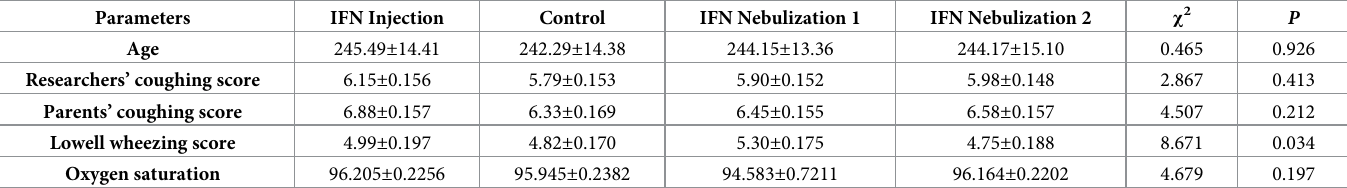
Table 2. The comparison of baseline data by the Kruskal—Wallis test.